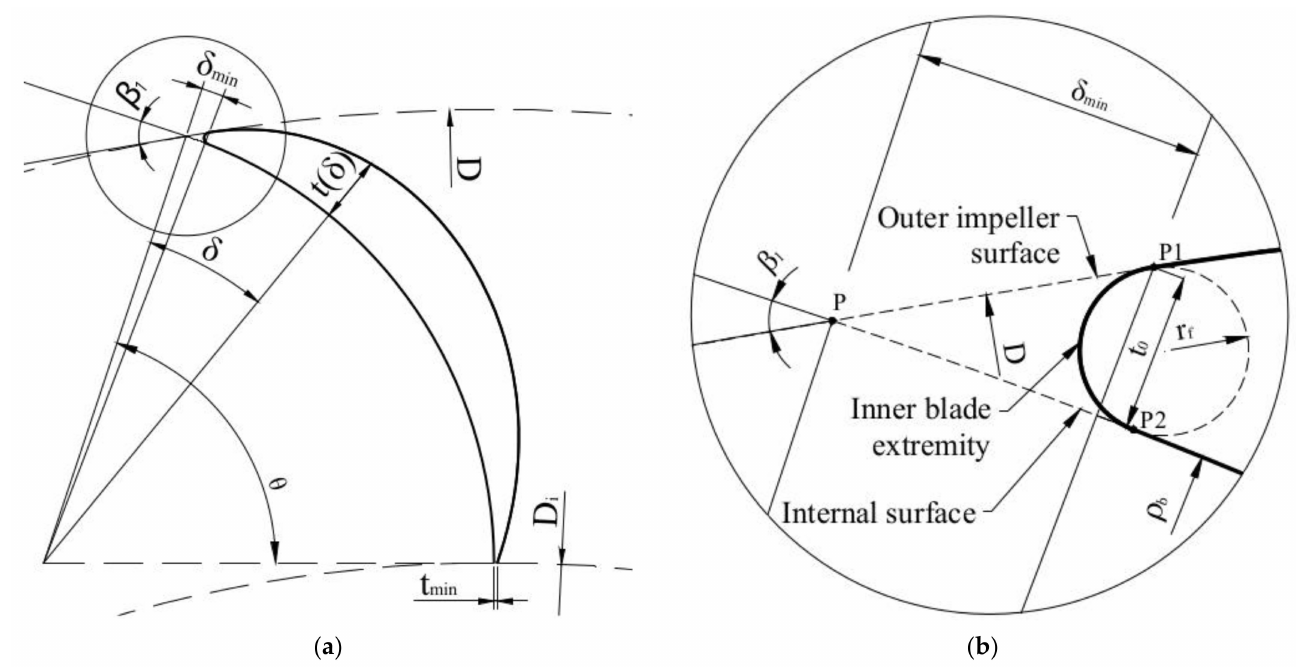
Figure 7. ( a ) Blade with new external profile; ( b ) tangent condition of external